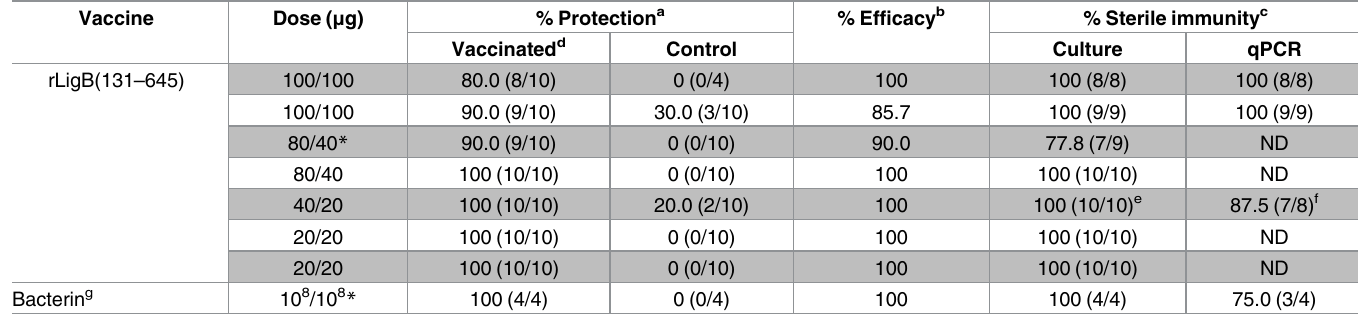
Table 1. Protection conferred by immunization with rLigB(131–645) against lethal challenge in the hamstermodel of leptospirosis.